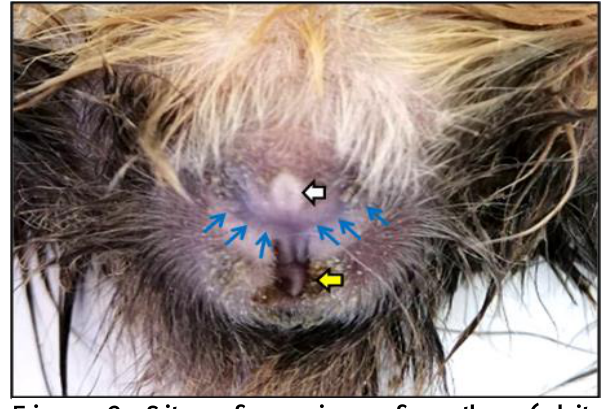
Figure 2. Sites of openings of urethra (white arrow), vagina (blue arrow) and anus (yellow arrow) Table 1. Macromorphometric measurements of